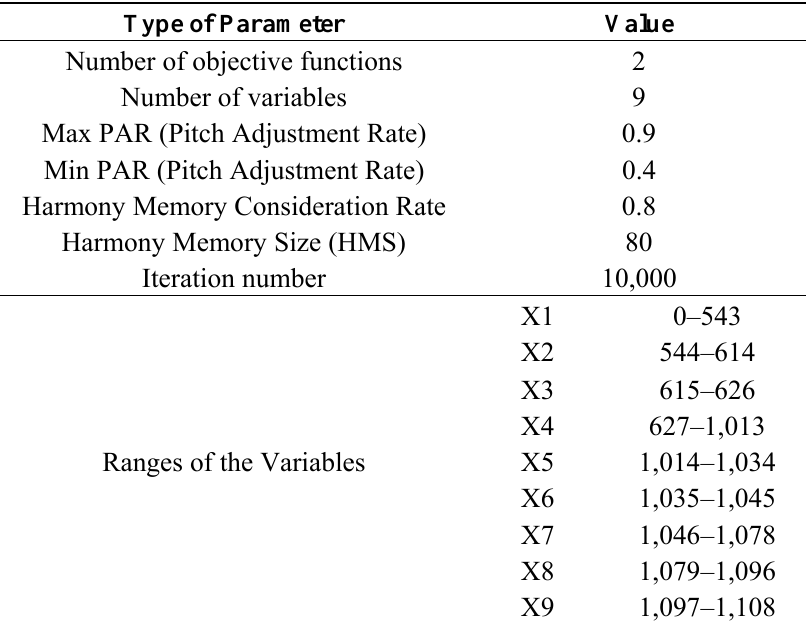
Figure 6. Model interface showing list of suppliers and building elements. Table 6. Harmony Search